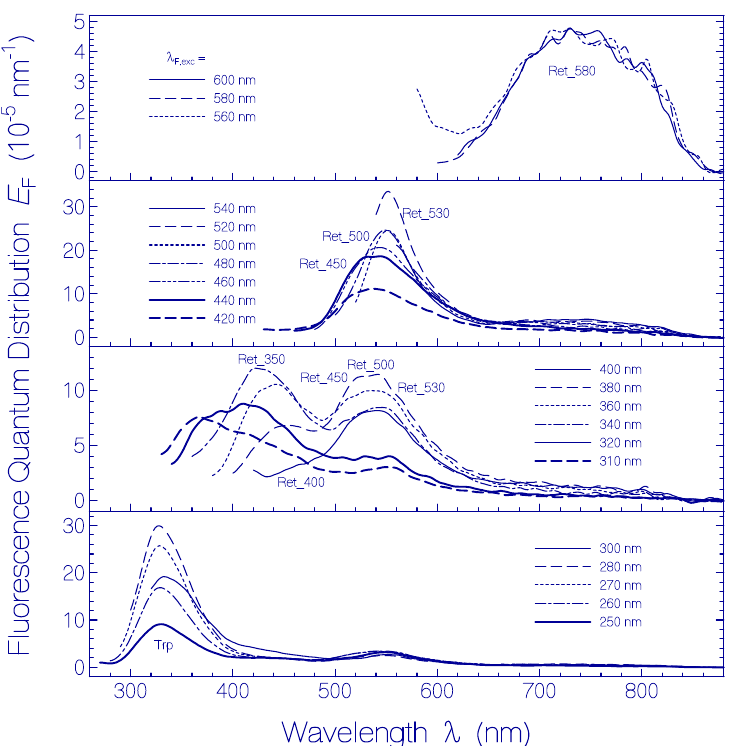
Figure 8. Fluorescence emission quantum distributions E F ( λ ) of QuasAr1 in pH 8 Tris buffer stored at room temperature ( ϑ = 21–25 °C) for a duration of 50 days. The fluorescence excitation wavelengths λ F,exc are listed in the legends.